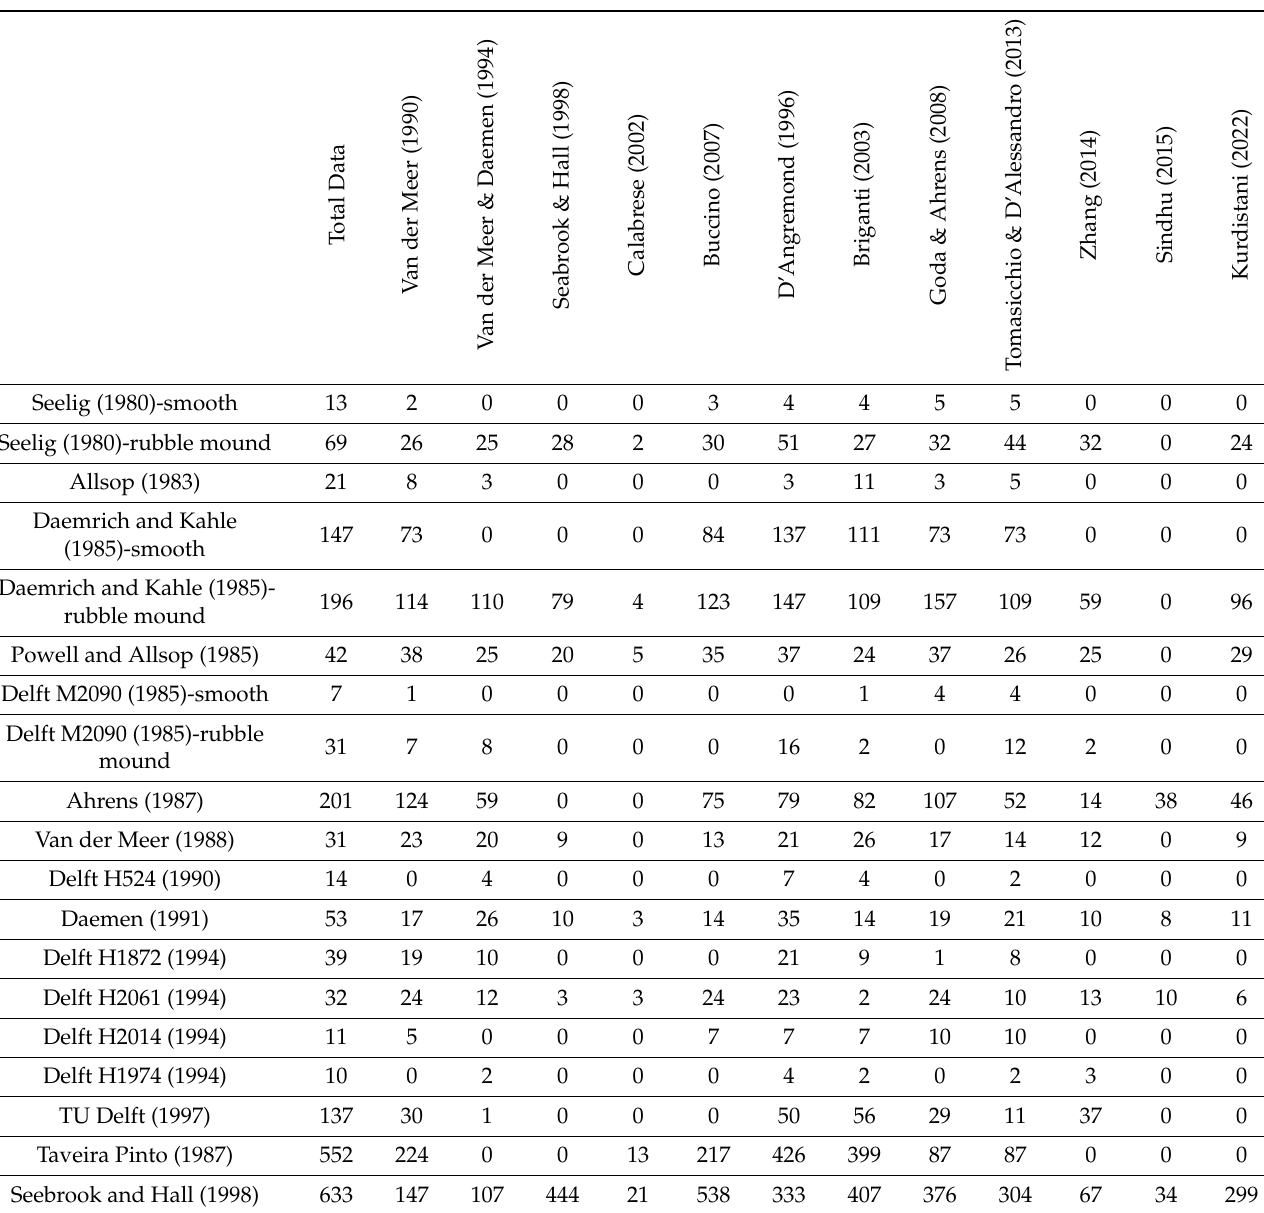
Table 4. Number and percentage of calculated data K t,cal in the interval ± 20% respect to K t,obs